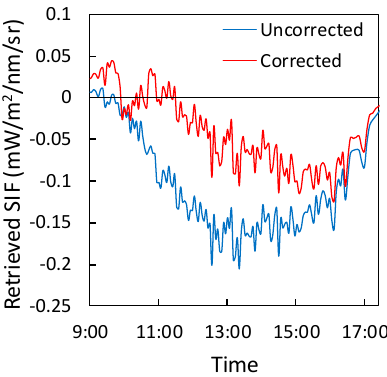
Figure 5. Results for SIF retrieved from tower-based spectral observations made on mature summer maize with no green leaves (measured on October 27, 2017, at Daman site). The blue line shows the results without atmospheric correction; the red line shows the results with atmospheric correction.